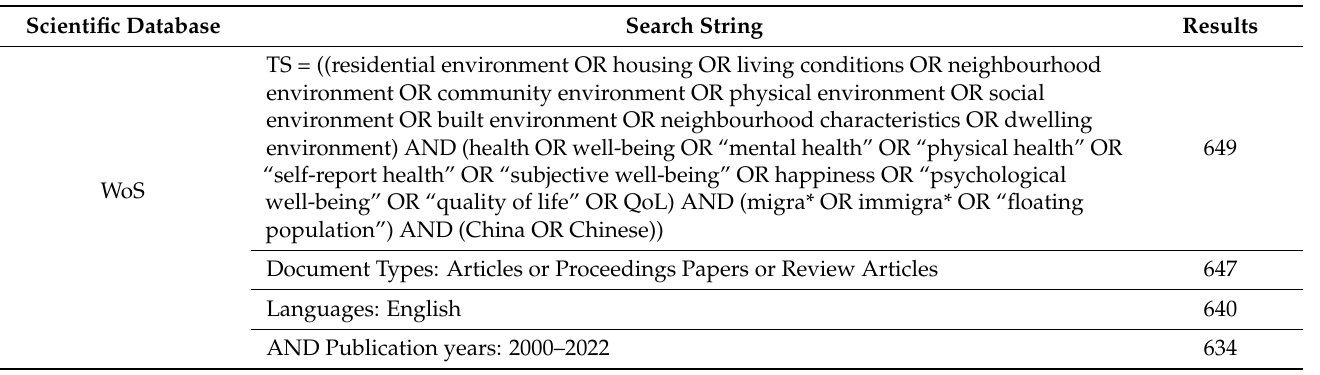
Table 2. The search string and results of the WoS, Scopus and CNKI